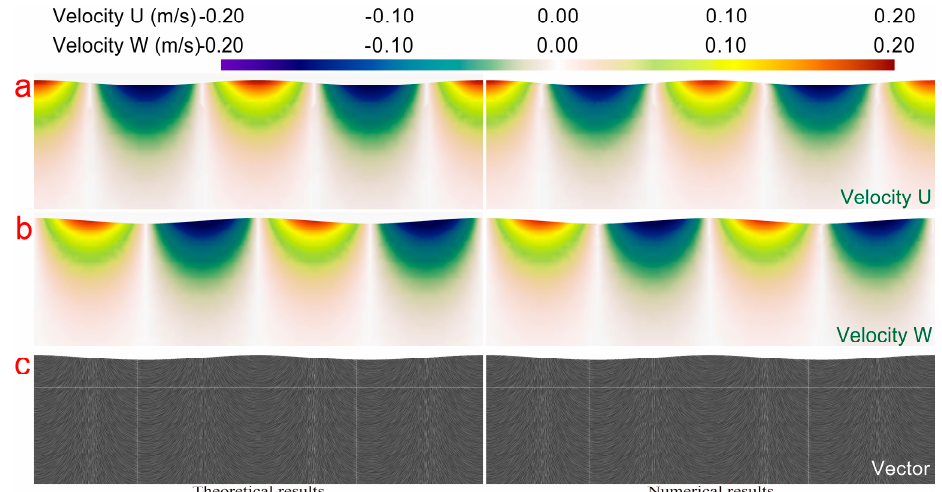
Figure 6. Comparison of wave velocity distribution. ( a ) Velocity distribution in the X direction; ( b ) Velocity distribution in the Z direction; ( c ) Distribution of the wave velocity vector.